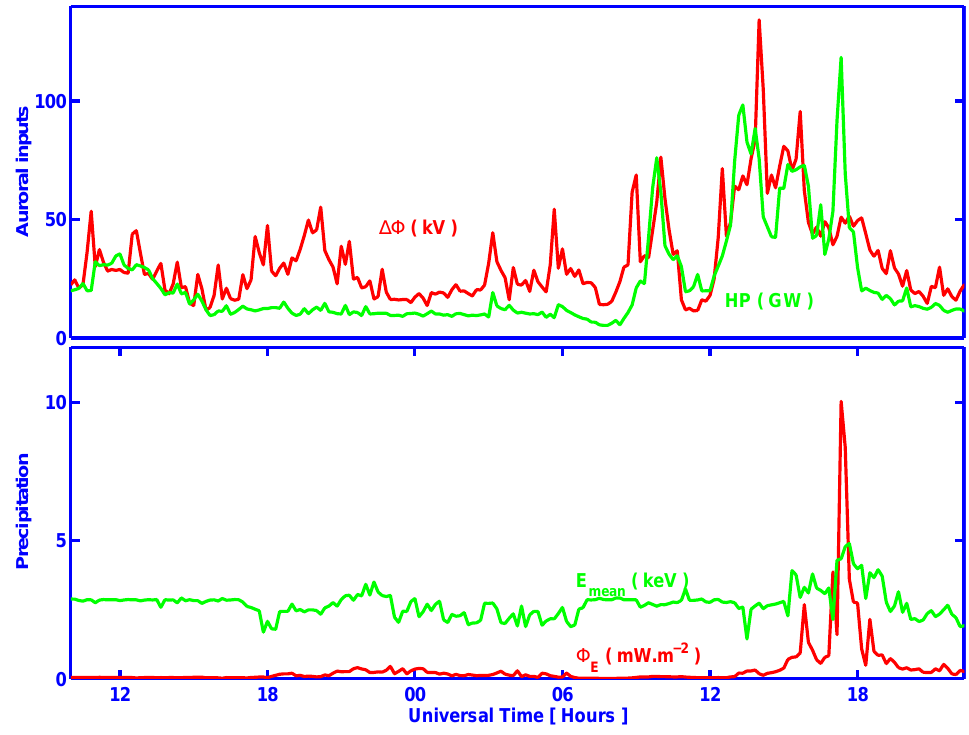
Fig. 6. Top: temporal evolution of the Northern Hemisphere cross polar cap potential ( 1φ in kV) and particle hemispheric power (HP in GW). Bottom: electron precipitation mean energy ( E mean in keV) and energy flux ( φ E in mW/m − 2 ) above Tromsø. Parameters computed by AMIE for the same period as Fig.